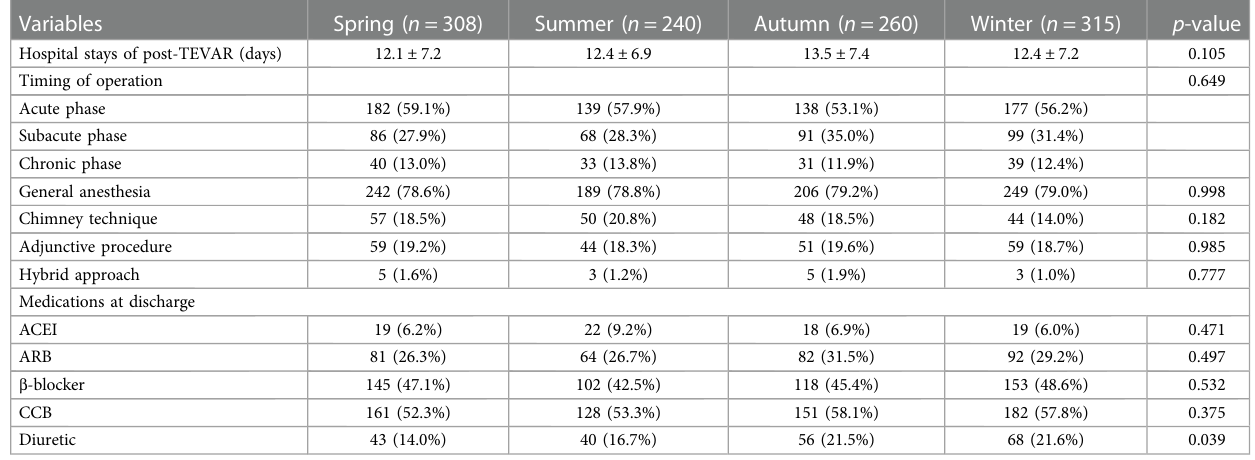
TABLE 2 Endovascular procedure and antihypertensive drugs strati fi ed with seasons of thoracic endovascular aortic